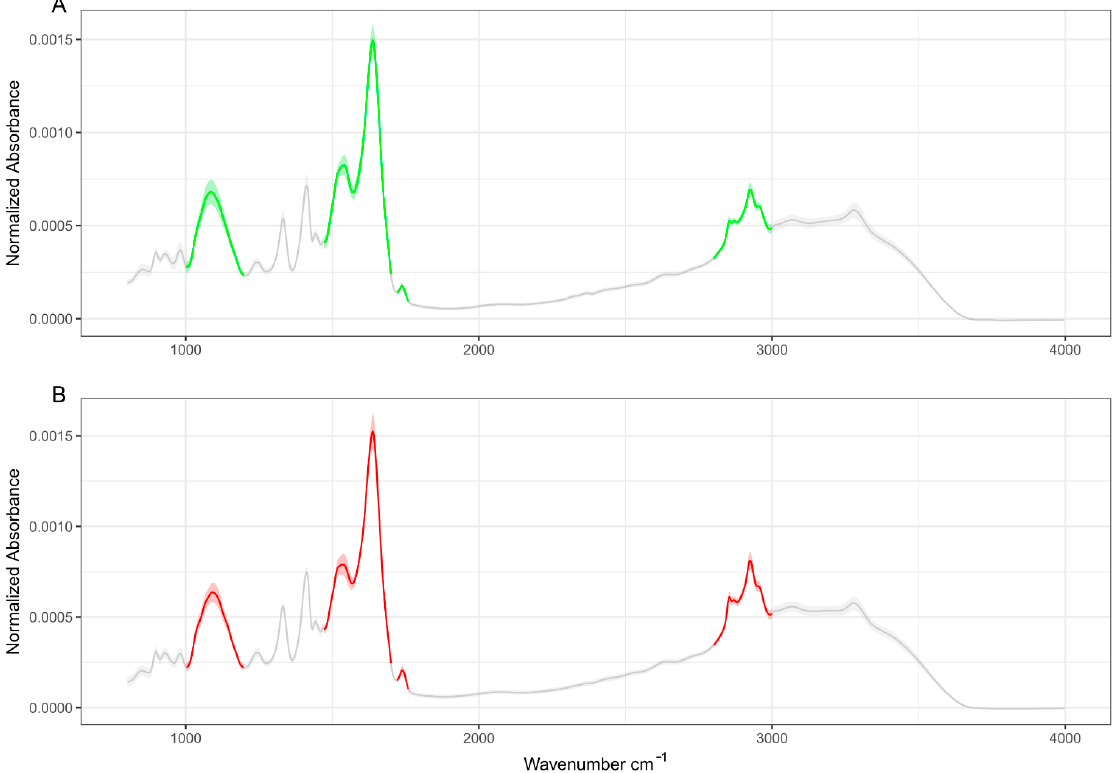
Figure 2. Average absorbance spectra of control subjects ( A ) and HCC patients ( B ). Data are reported as mean ± 95% confidence bands. The analysis performed in this study is principally focused on the highlighted green (controls) and red (patients) bands.